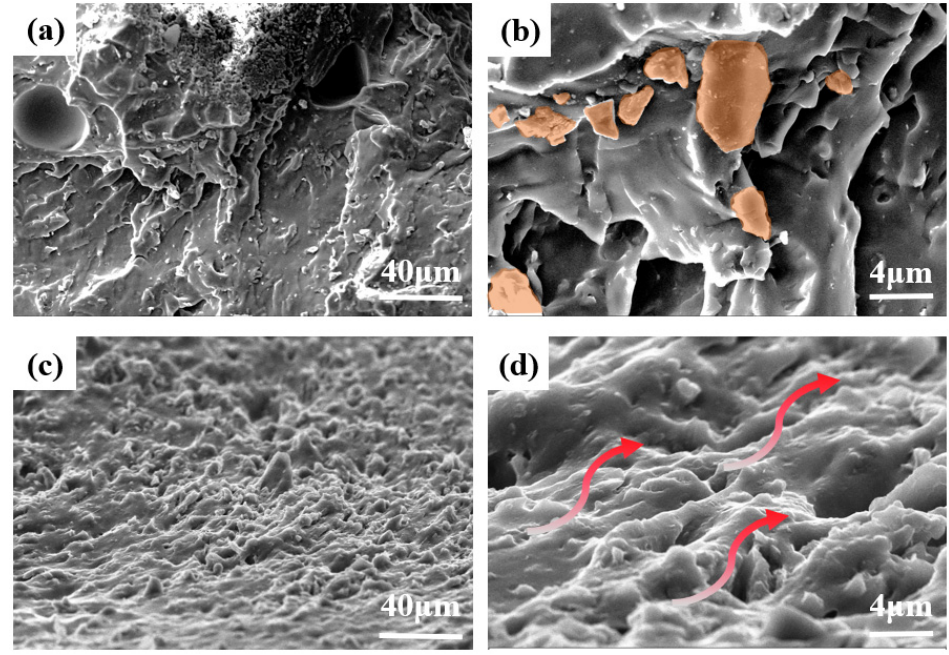
Figure 5. Cross-section morphology of ( a , b ) BN 1 LMPA 2 /SG and ( c , d ) BNG 1 LMPA 2 /SG.